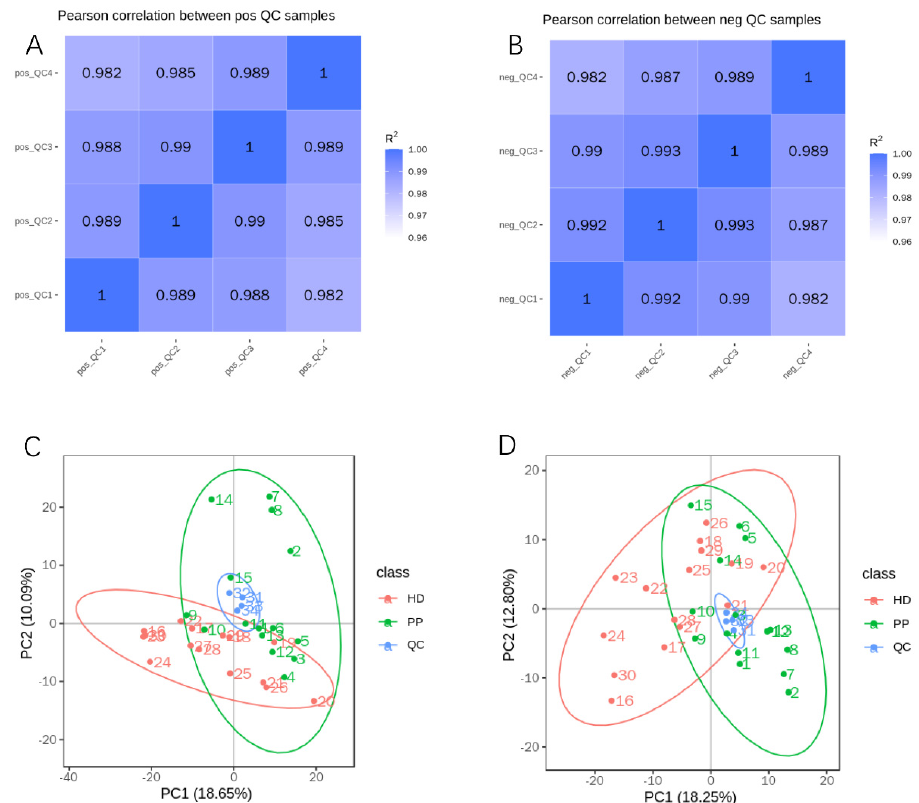
Figure 2. The quality control of untargeted metabolic profiling. ( A , B ). Pearson correlation analysis between QC samples: the coefficient (R2) values were both nearly 1 under the positive ( A ) or negative ( B ) polarity modes; ( C , D ). PCA analysis: QCs tightly aggregated into a cluster in the positive ( C ) and negative ( D ) ion modes.